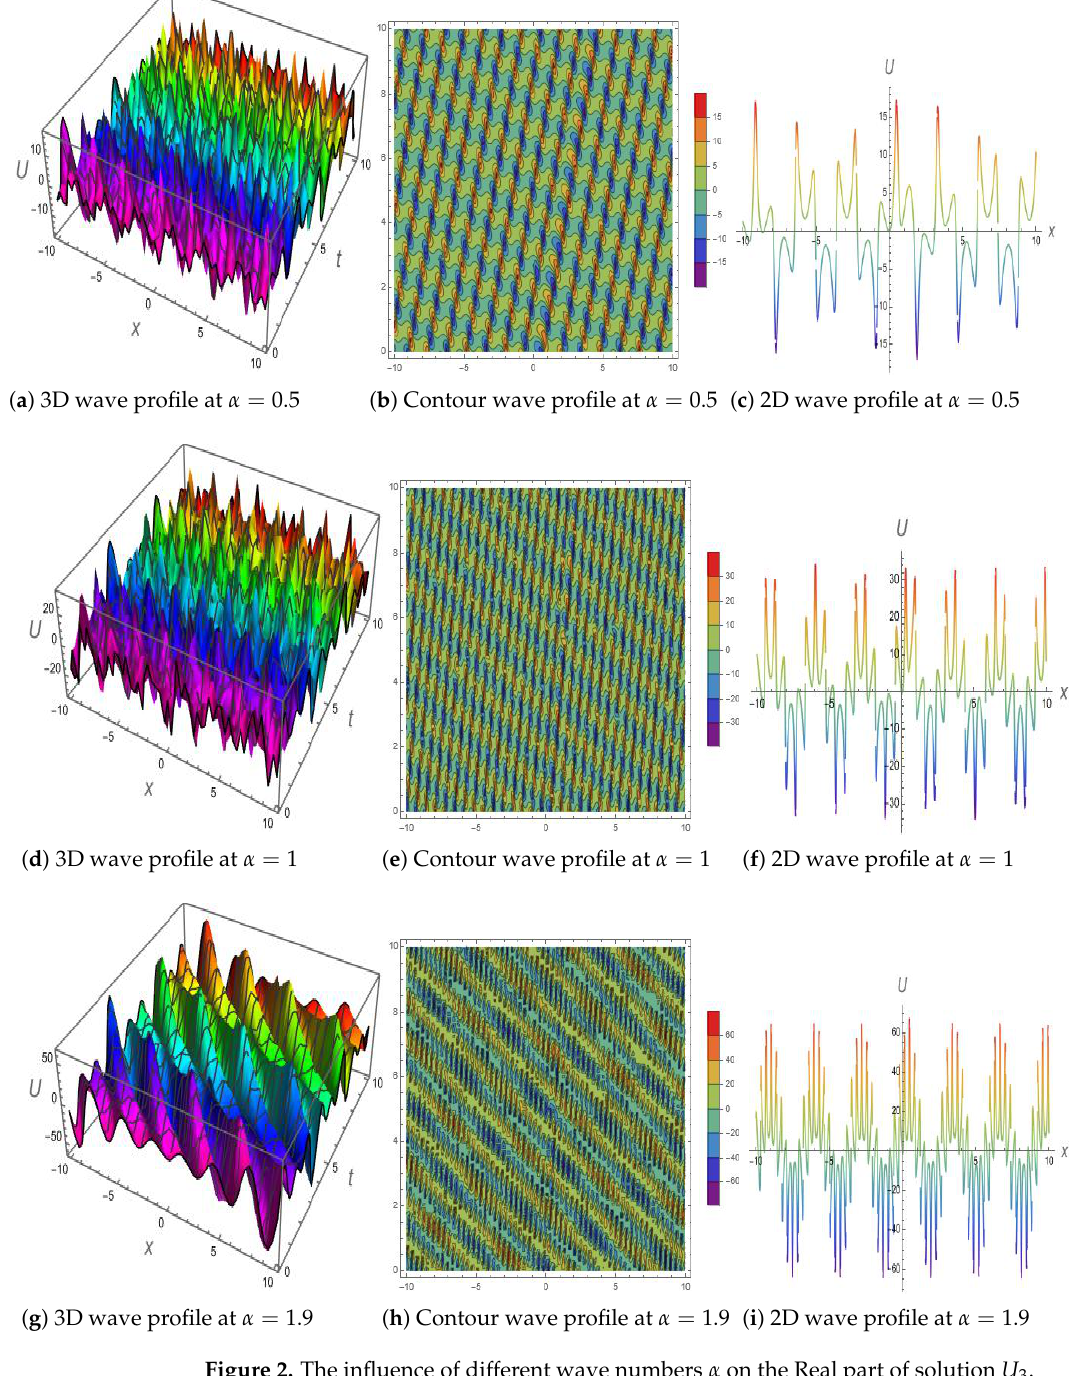
Figure 2. The influence of different wave numbers α on the Real part of solution U 3